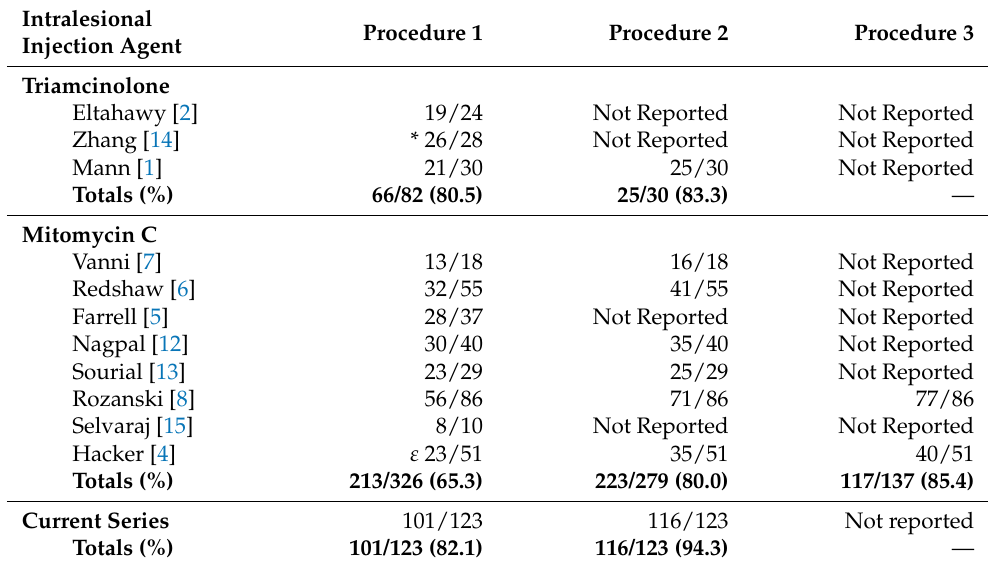
Table 4. Average surgical success rates by intralesional injection